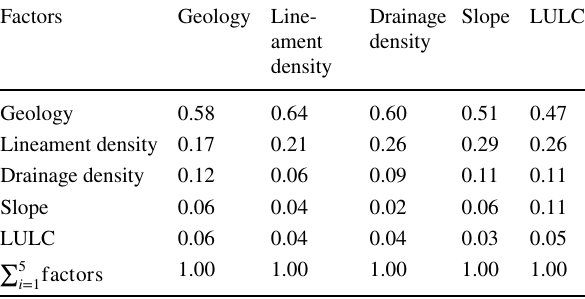
Table 5 Normalized relative weight of influencing factors Factors Geology Line-